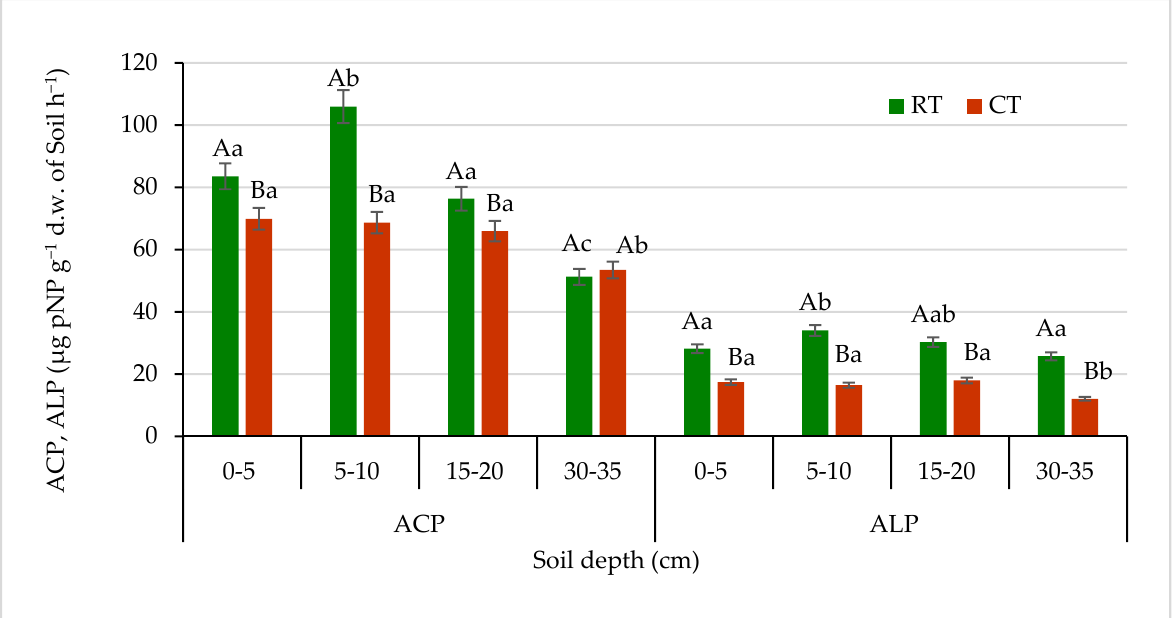
Figure 10. Acid phosphatase (ACP) and alkaline phosphatase (ALP) activities in soil under different tillage systems in 2018–2020 (expressed as means for the 3 years, n = 12). Different letters represent significant differences ( p ≤ 0.05) across treatments according to Tukey’s HSD test; lowercase letters within the same tillage system indicate significant differences between soil depths; uppercase letters indicate differences between tillage systems. RT—reduced tillage system; CT— conventional tillage system; d.w.—dry weight of soil; n —number of samples. Vertical bars represent standard errors.